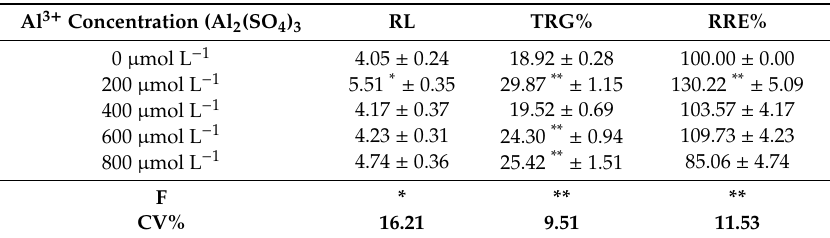
Table 2. Mean root length (RL), total root growth rate (TRG%) and relative root elongation (RRE%) of the Eugenia dysenterica root system after 20 days grown in solution at various Al concentrations (0, 200, 400, 600 and 800 µ mol L − 1 ).